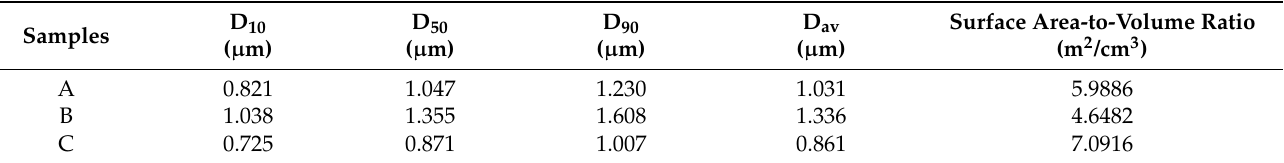
Table 3. Particle size parameters of the ZOD sample (A), the conventional leaching residue (B), and the ultrasonic leaching residue